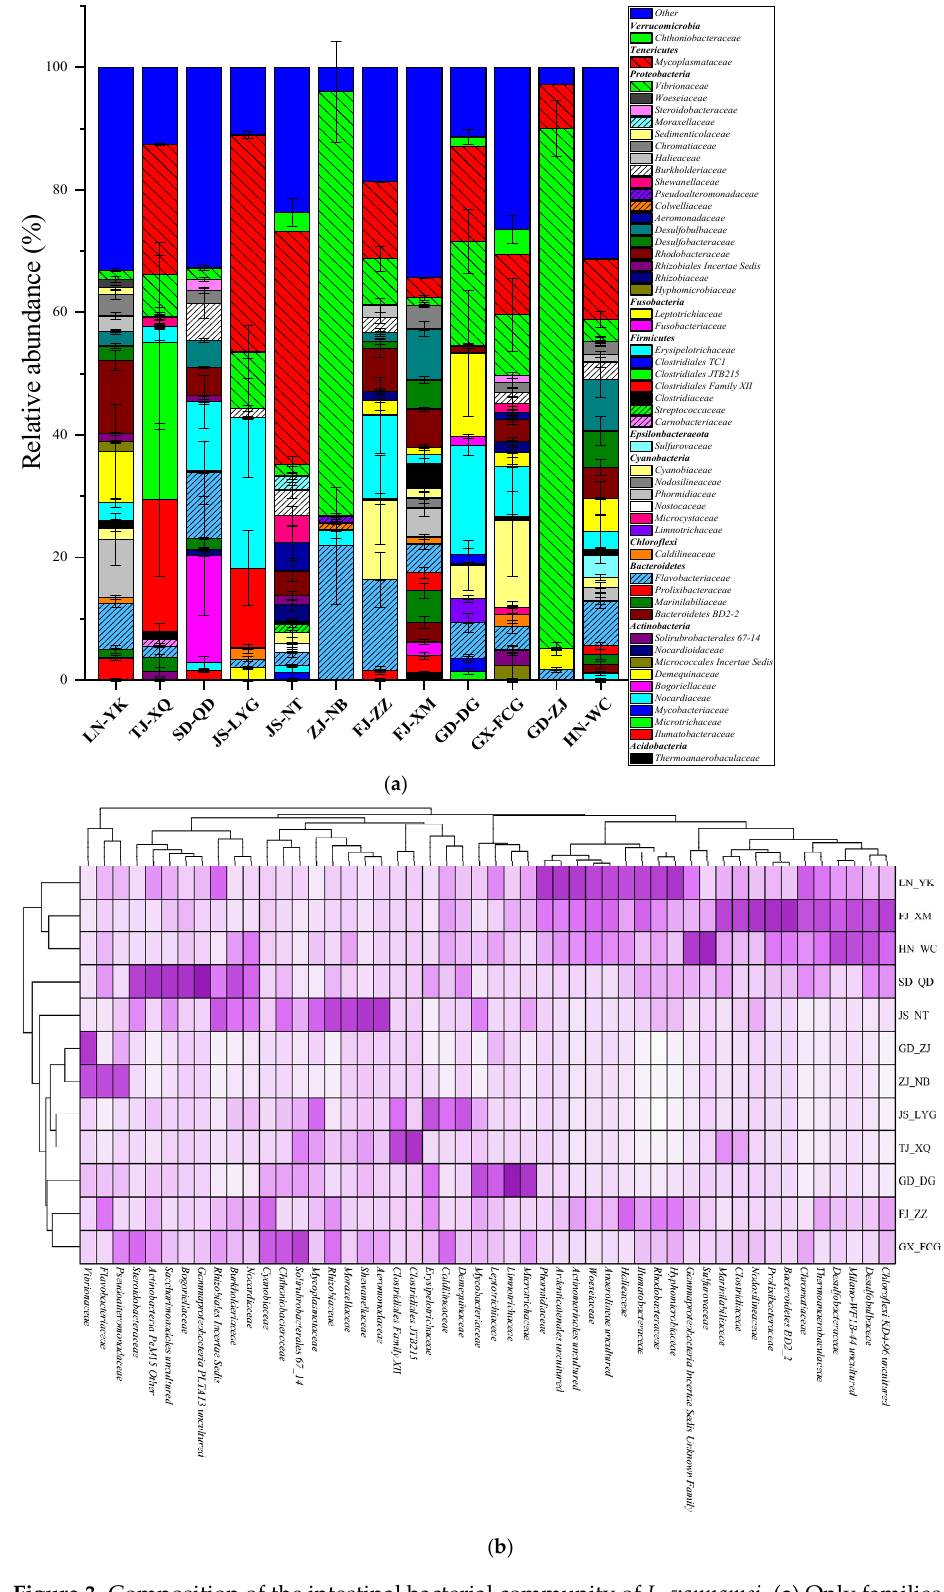
Figure 3. Composition of the intestinal bacterial community of L. vannamei . ( a ) Only families with an average relative abundance >1% are shown here (see Table S1 for abbreviations). The relative abundance of each family in the same group is indicated by color intensity. ( b ) Heat map showing the distribution of the top 50 abundant families in the intestinal bacterial communities. Relative abundance percentage values for the bacterial families are indicated by color intensity.